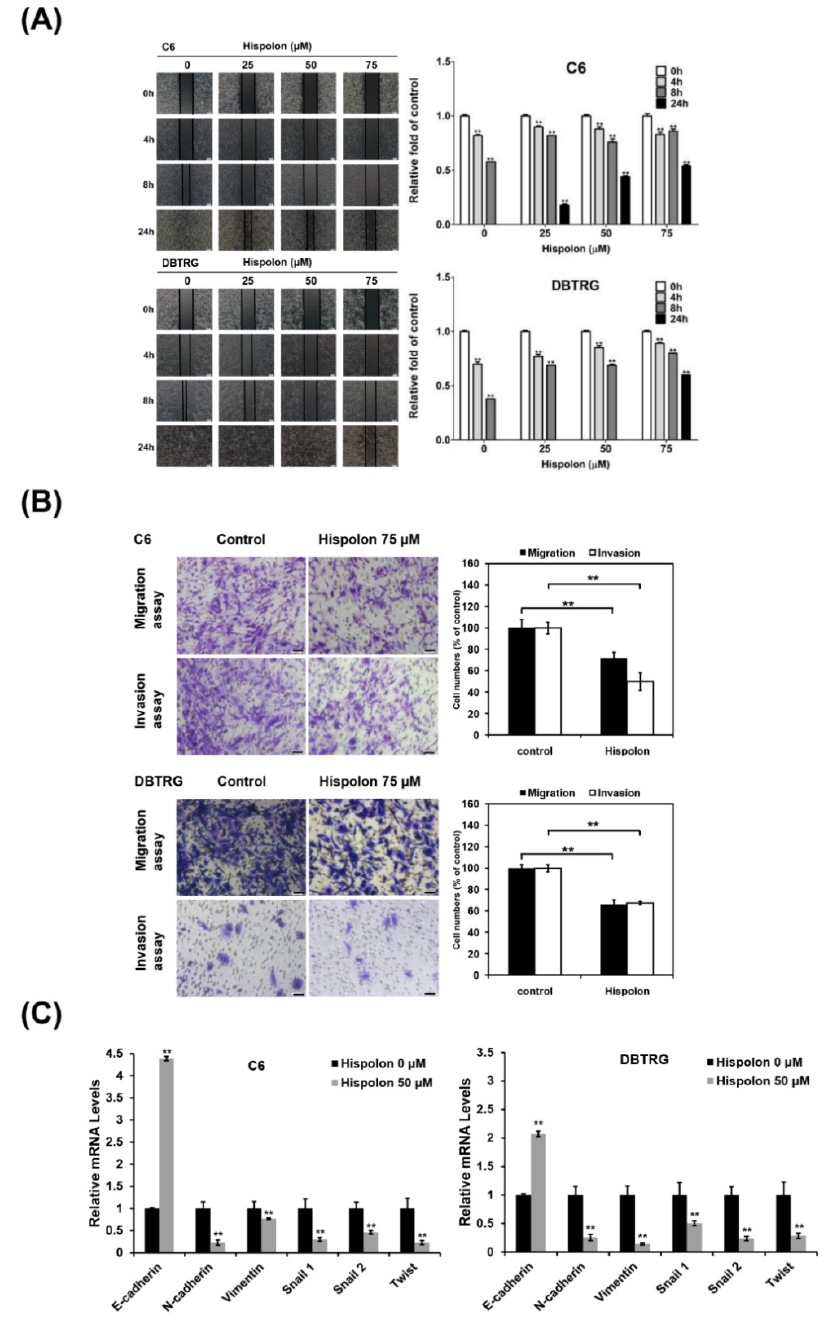
Figure 3. The antimetastasis effect of hispolon in GBM cells. ( A ) Hispolon inhibits C6 and DBTRG cell migration in a dose-dependent manner analyzed through the wound-healing assay. Images were captured using a microscope with 100 × magnification; scale bar, 100 µ m. ( B ) GBM cells were pretreated with 75 µ M hispolon for 24 h and seeded onto the transwell hanging insert coating with (invasion) or without (migration) Matrigel for 24 h. Images were captured in 200 × magnification and quantified by enumerating the stained cells that migrated onto the bottom of the hanging insert; scale bar, 50 µ m. ( C ) GBM cells were treated with 50 µ M hispolon for 24 h followed by qRT-PCR analysis. The mRNA expression levels of E-cadherin, N-cadherin, vimentin, Snail 1, Snail 2, and Twist were determined. Data are presented as means ± SD from three different experiments. ** p < 0.01 versus